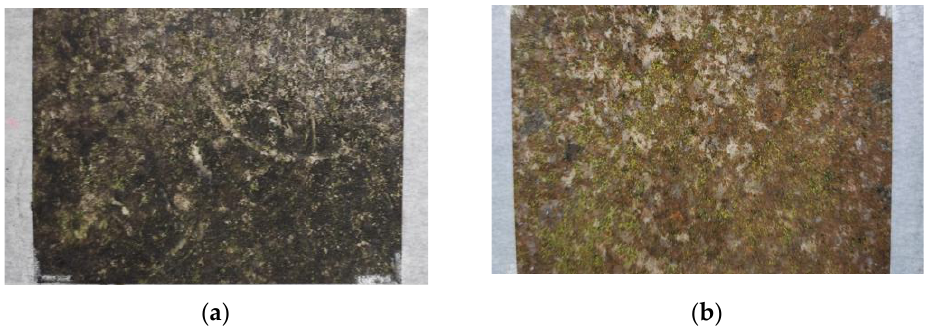
Figure 1. Experimental surfaces (details). In the pictures, the two surfaces are compared. In ( a ) the dark green biopatina is shown (Surface a), and in (b) the green-orange biopatina is shown (Surface